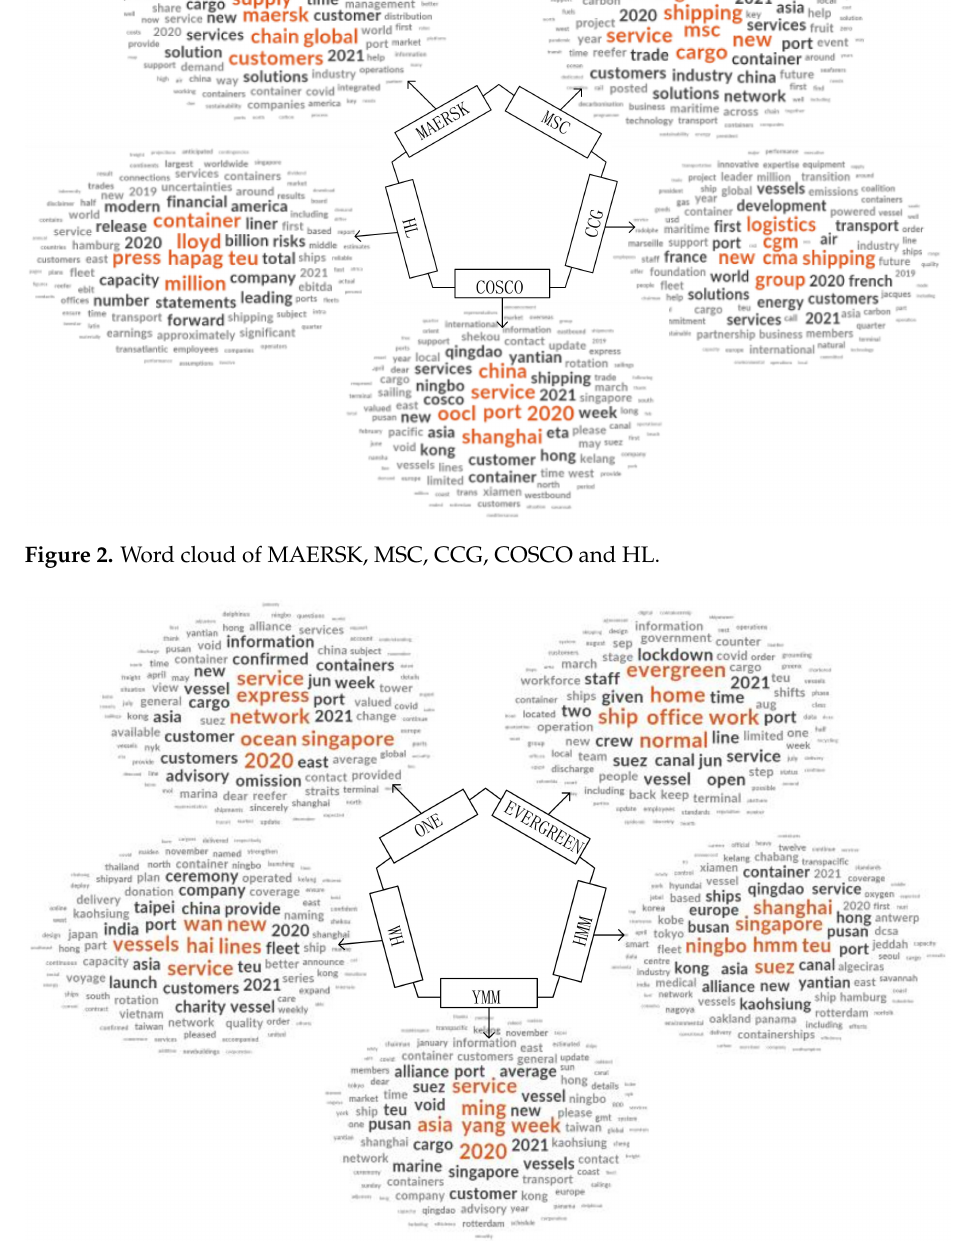
Figure 3. Word cloud of ONE, EVERGREEN, HMM, YMM and